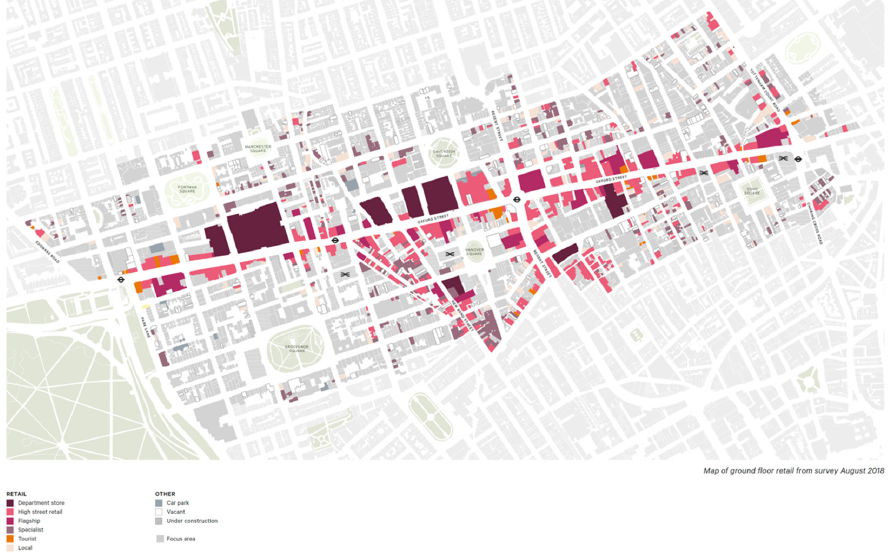
Figure 6. OSD ground-floor retail ( Reprinted with permission from ref. [28]. Copyright 2019 Pub- lica.)